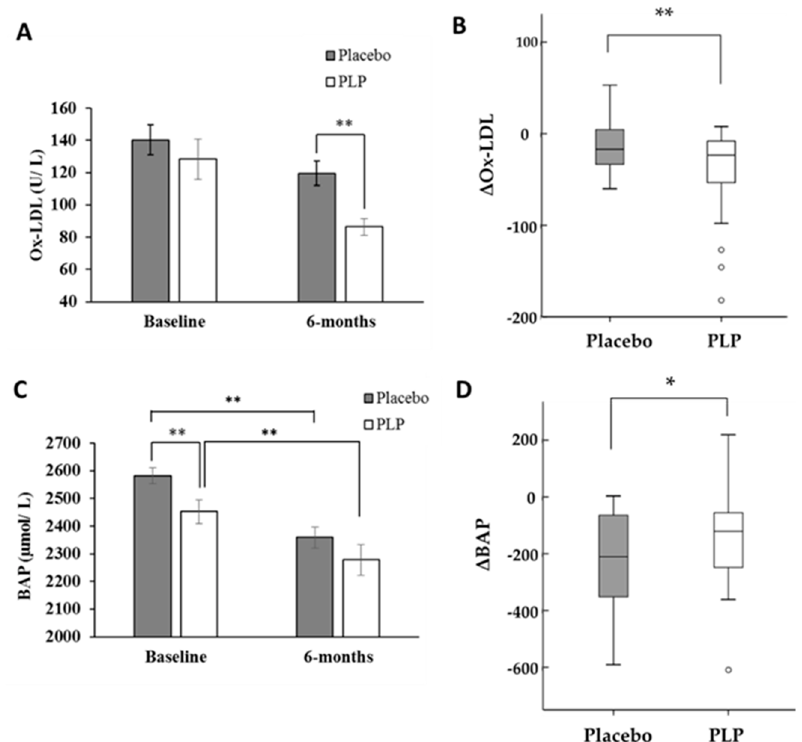
Figure 2. Changes of serum-oxidized low-density lipoprotein (Ox-LDL) ( A , B ) and biological antioxidant potential (BAP) ( C , D ) in the placebo and Perilla frutescens leaf powder (PLP) groups. ( B , D ) indicate the mean changes ( ∆ ) in Ox-LDL and BAP levels from baseline to month 6 in each group. Vertical bars represent the standard error of mean ( A , C ) or interquartile range ( B , D ). ** P < 0.05, * 0.05 < P < 0.1.